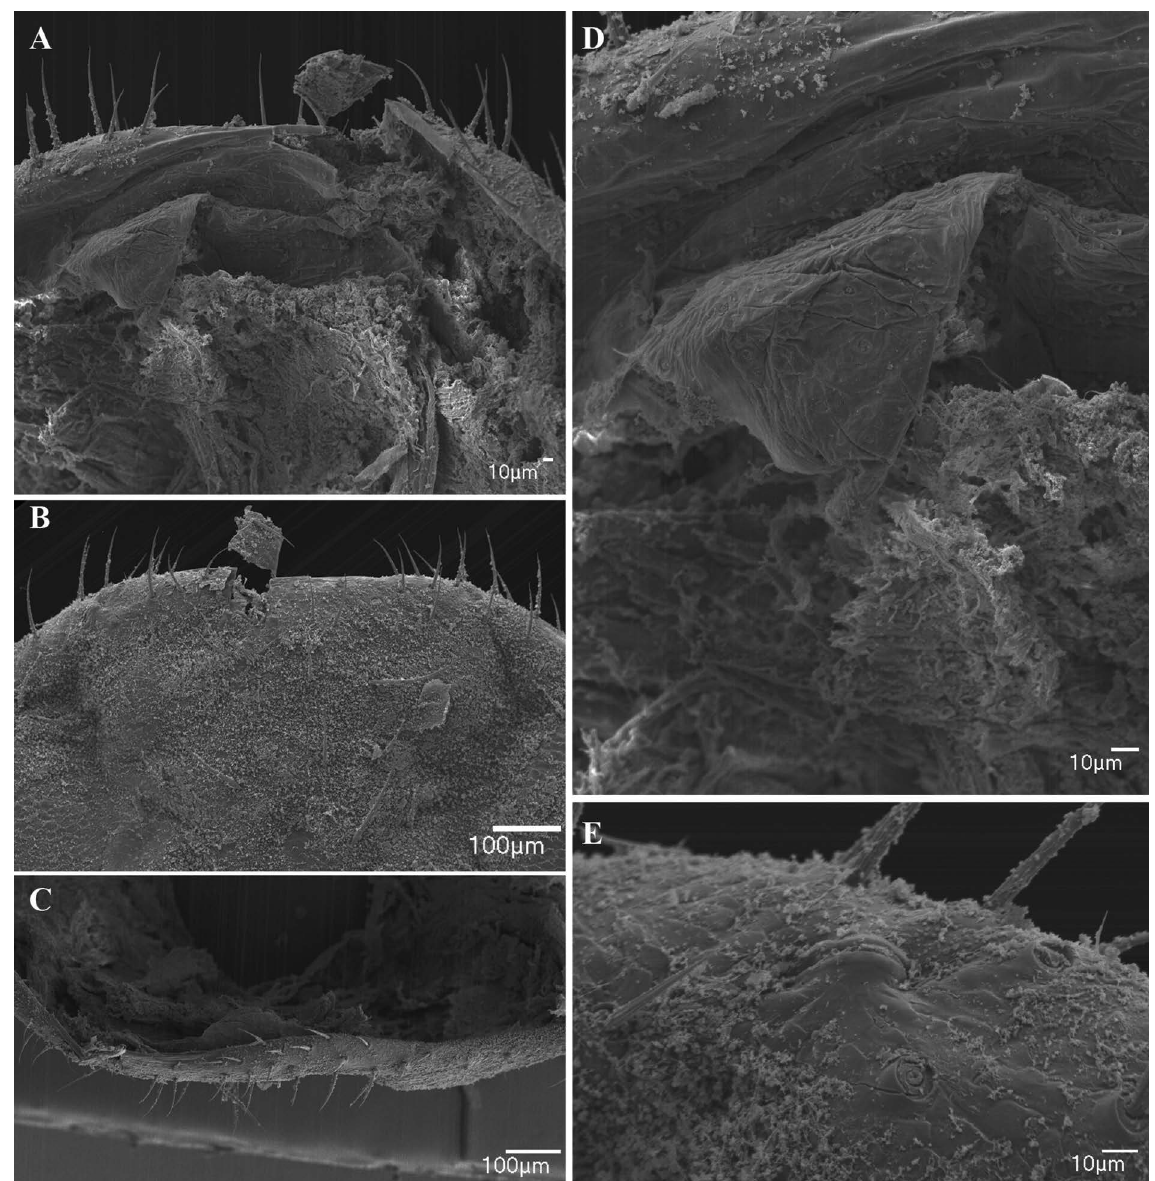
Fig. 146. Sarax seychellarum (Kraepelin, 1898) comb. nov. (AMCC [LP 9075]), female gonopod and genital operculum. A . Gonopod, dorsal view. B . Posterior margin of genital operculum, ventral view. C . Gonopods, posterior view. D . Sinistral side of gonopod. E . Glandular opening on margin of genital